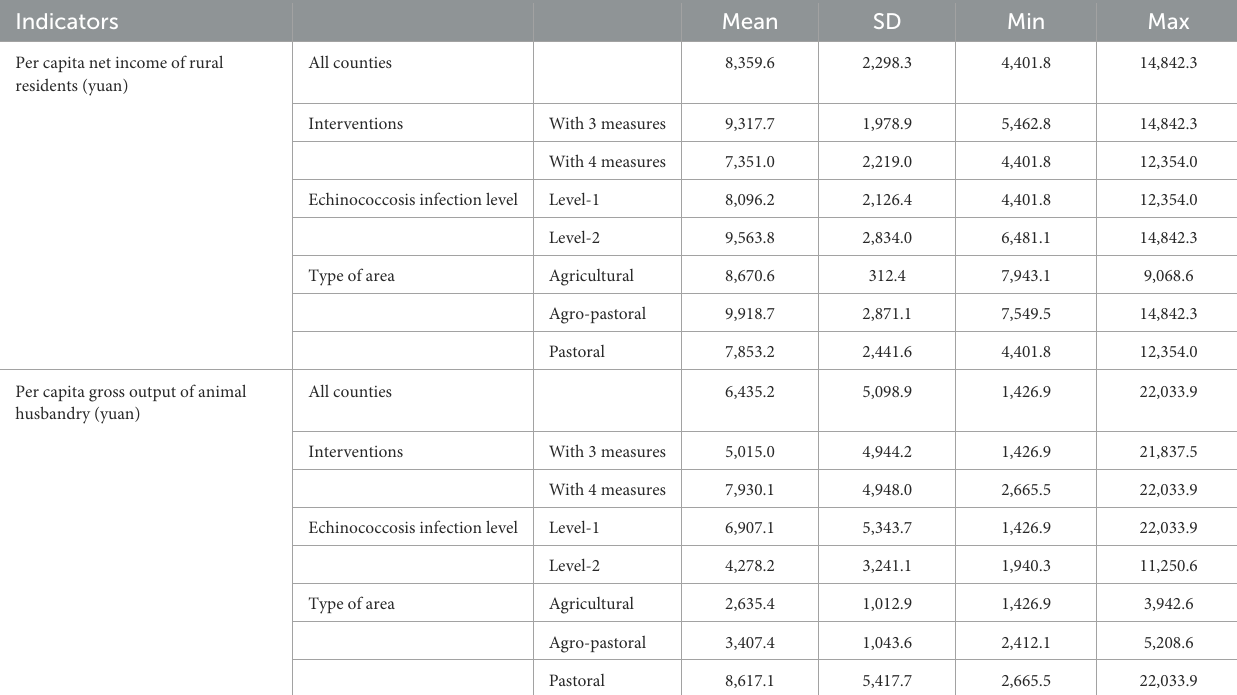
TABLE 2 Economic characteristics of sampled counties in 2016 (the starting year of echinococcosis interventions). Indicators